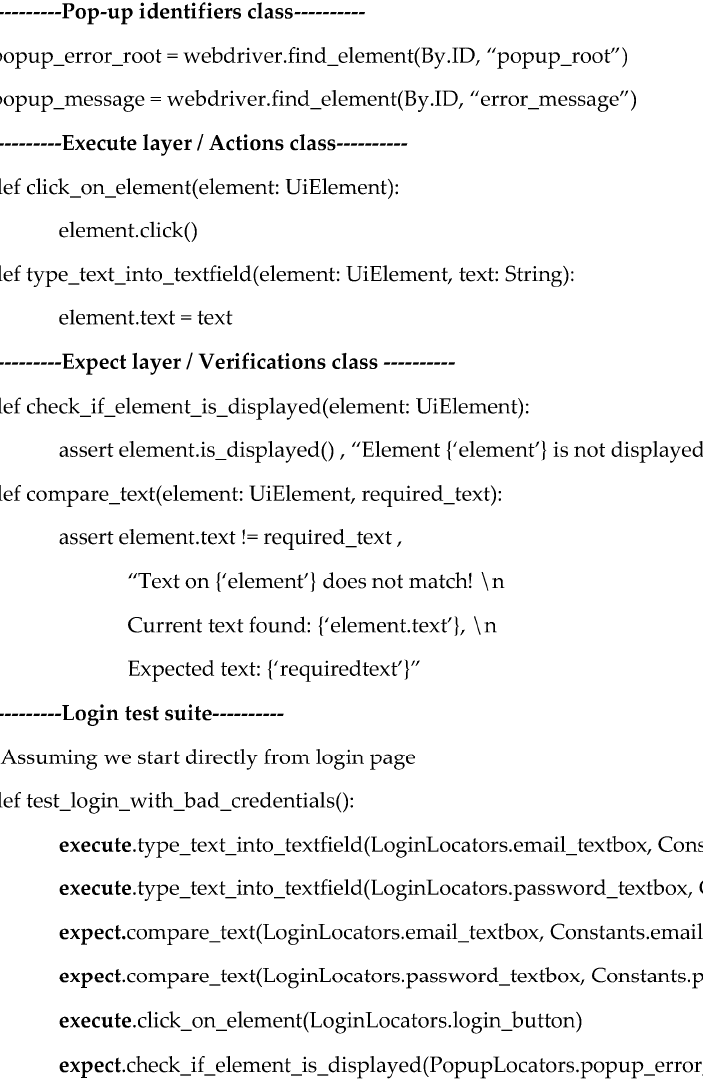
Figure 12. Pseudo-code of the login test example [16].